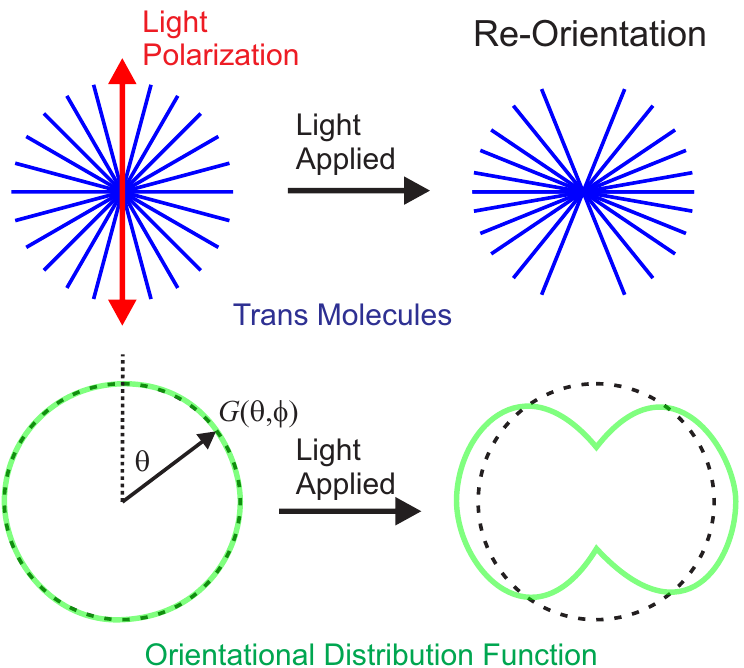
Figure 2. After the hole is “burned” into the material as shown in Figure 1, the cis molecules decay back into the trans state with no preferred orientation. The net effect is that trans molecules oriented along the light’s polarization axis are converted into the orthogonal